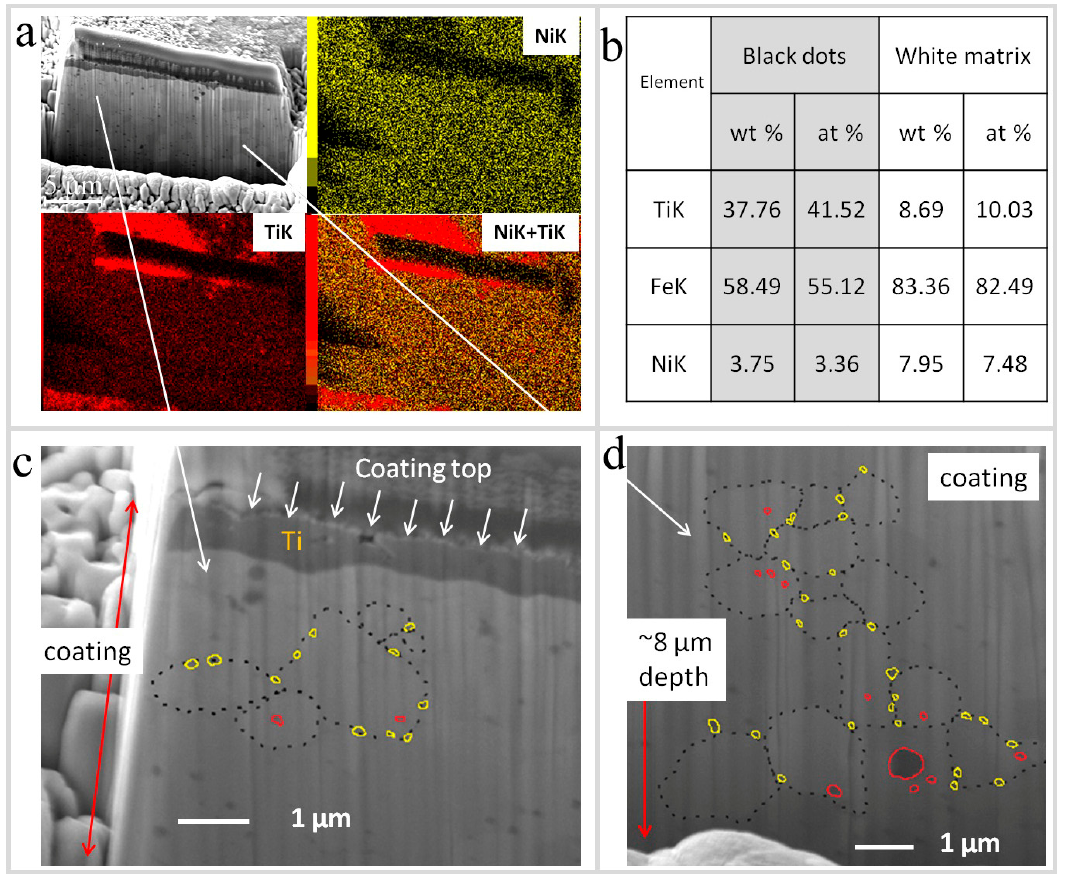
Figure 5. ( a ) A cross-sectional view of Ni-Ti coating on the hypoeutectoid steel substrate after 1-h treatment and the laser treatment E = 13.6 J/mm 2 ; ( b ) element analysis data, a table of the element content in the cross-sectional area; ( c , d ) magnified SEM image of visible grain boundaries of the steel matrix and embedded/recrystallized intermetallic incorporations.